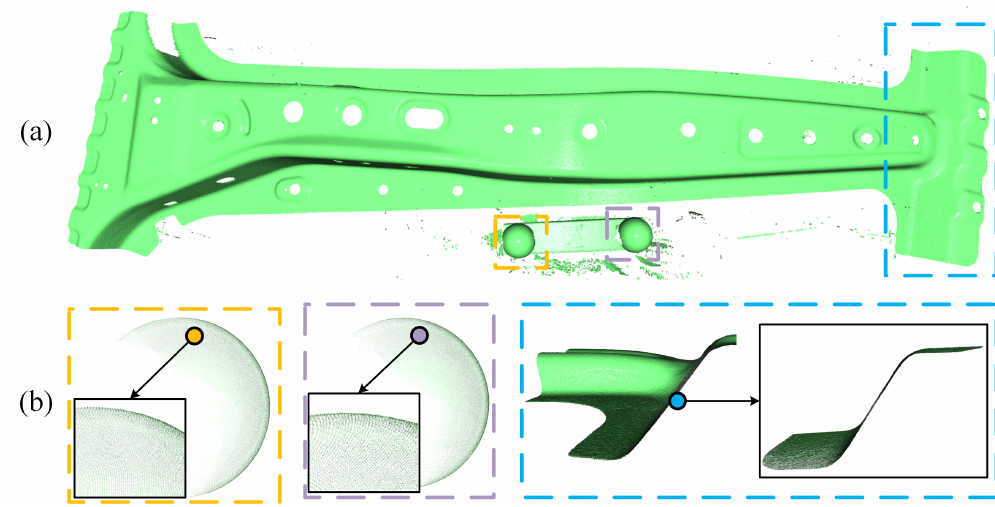
Figure 10. ( a ) The reconstructed surface after global optimization, ( b ) Its local details.